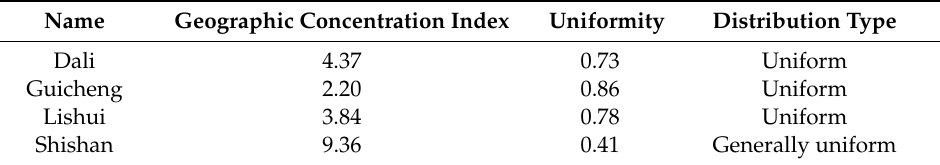
Table 4. Distribution type of blue steel sheds in each town.